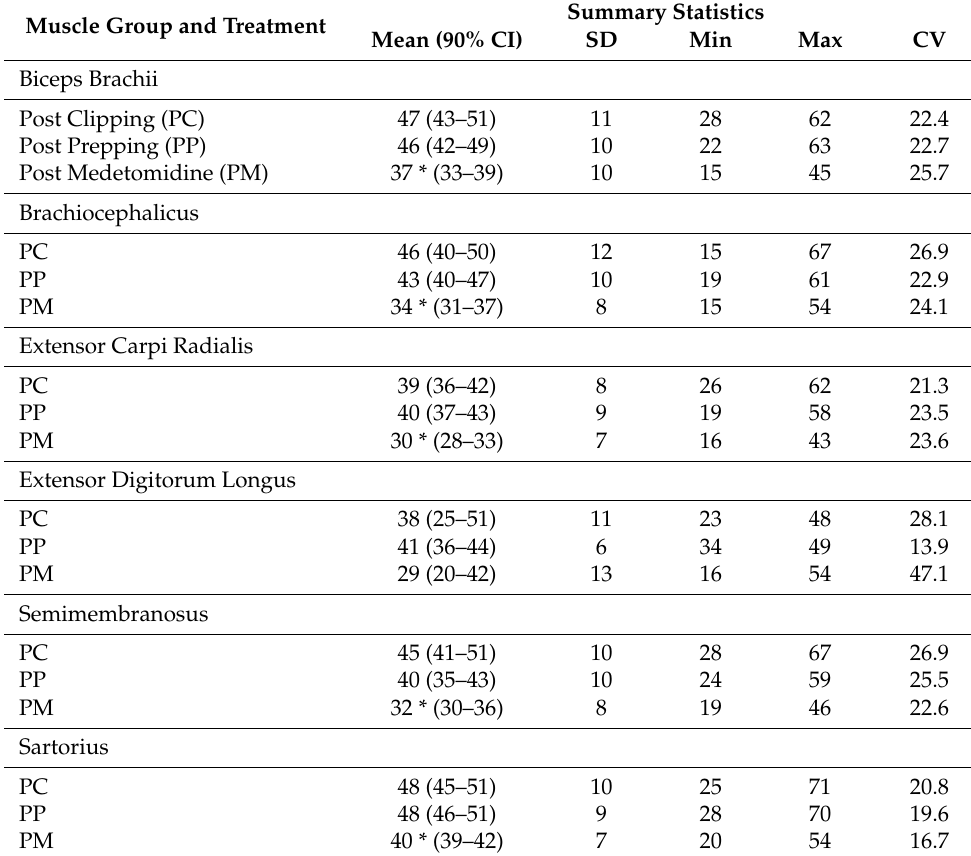
Table 3. Summary statistics for tissue oxygen saturation (StO 2 %), measured on different muscles in 50 horses following 3